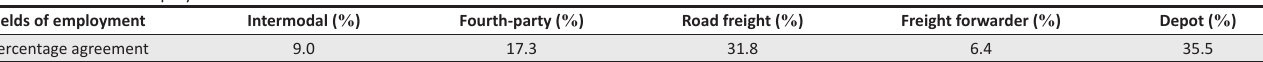
TABLE 2b: Fields of employment. Fields of employment